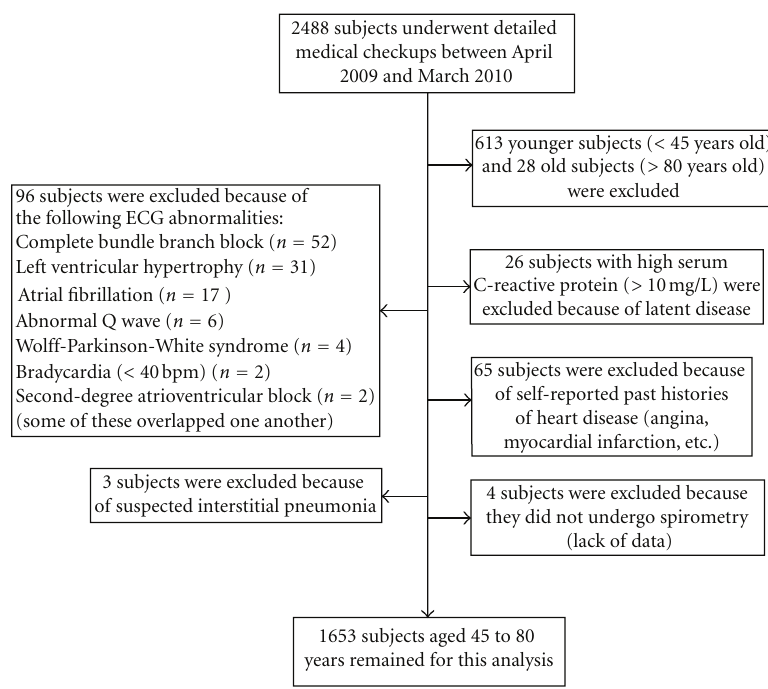
Figure 1: Exclusion criteria of subjects and flow